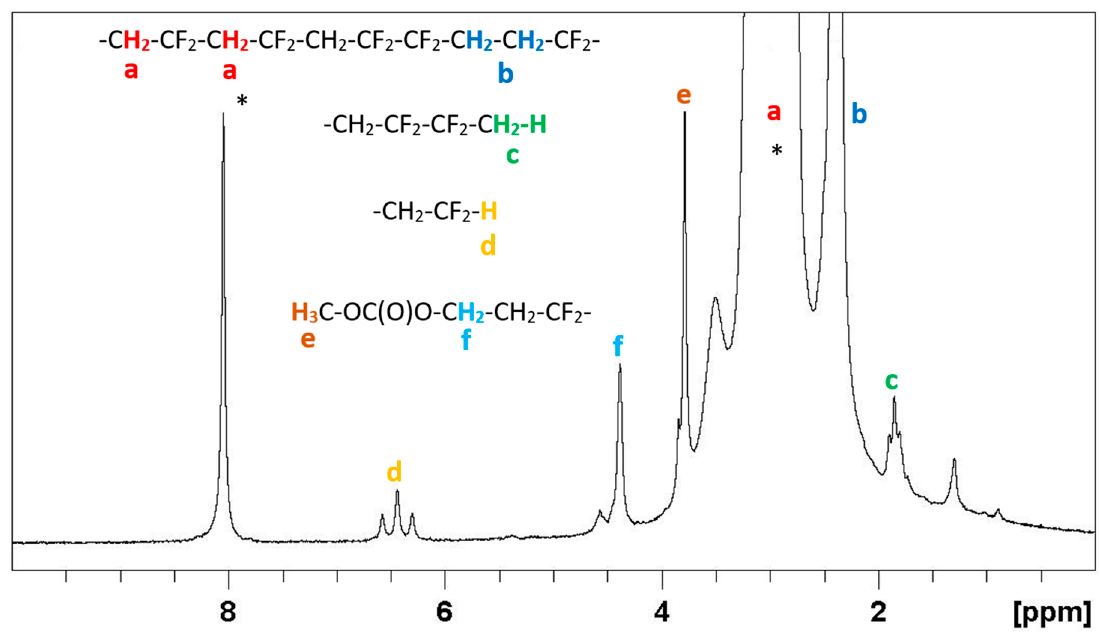
Figure 3. 1 H NMR spectrum (400 MHz, DMF- d 7 ) between 0 and 10 ppm of the PVDF obtained by thermal activation of 1 (entry 7 of Table 1). The full spectrum is shown in the SI (Figure S9). The starred resonances are due to the solvent.